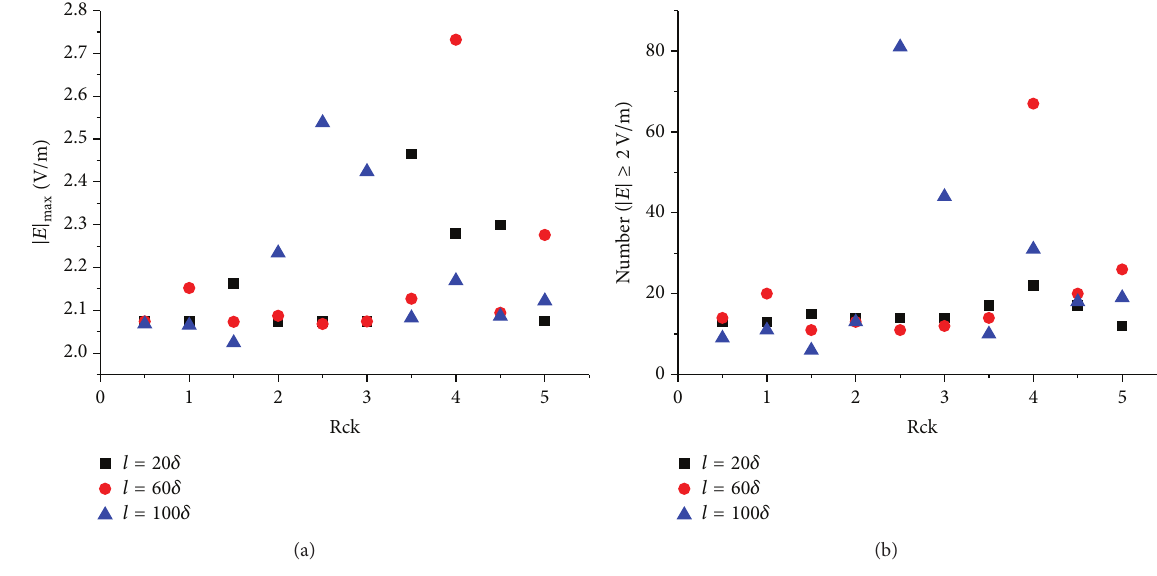
Figure 7: (a) |𝐸| max and (b) the number of high-intensity spots as the function of Rck .